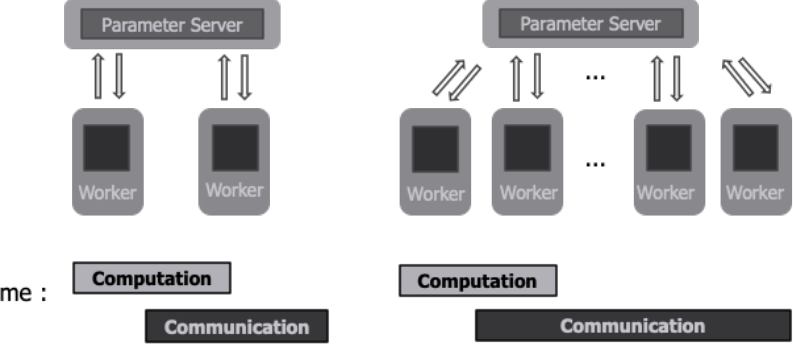
Figure 1. Communication time increases as the number of workers